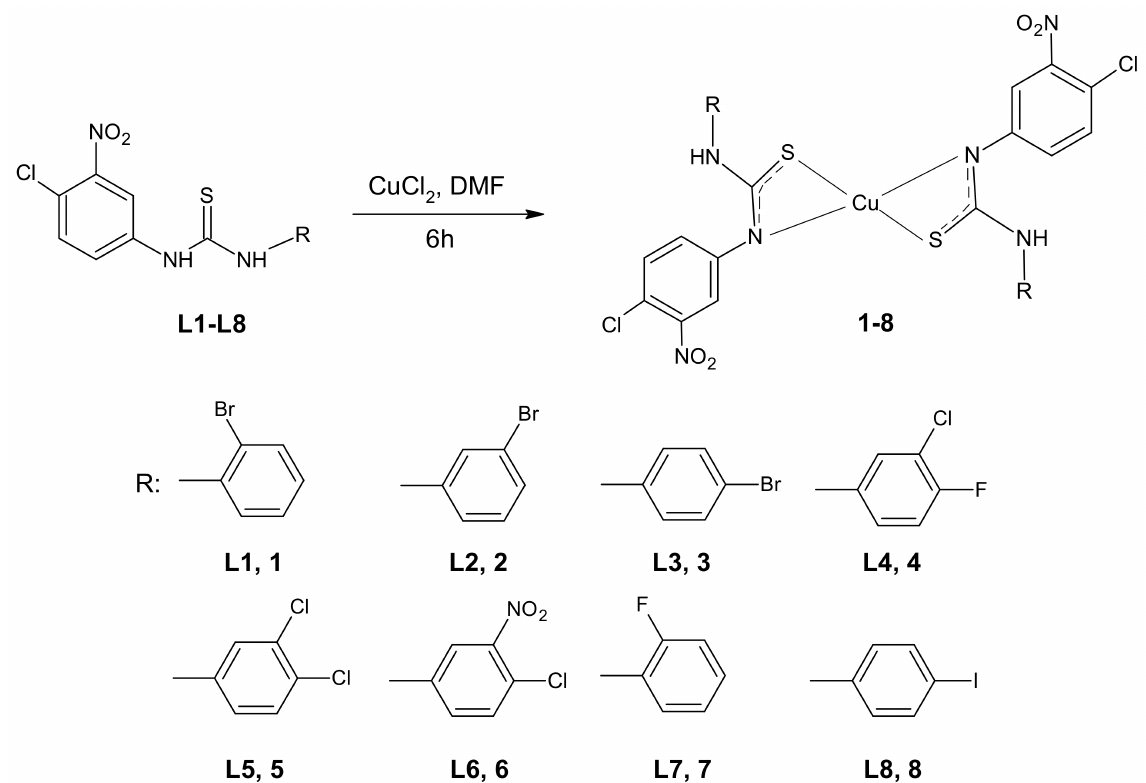
Figure 1. Scheme of the complexation reaction of the respective arylthiourea ligands L1 – L8 with proposed molecular structures of complexes 1 – 8